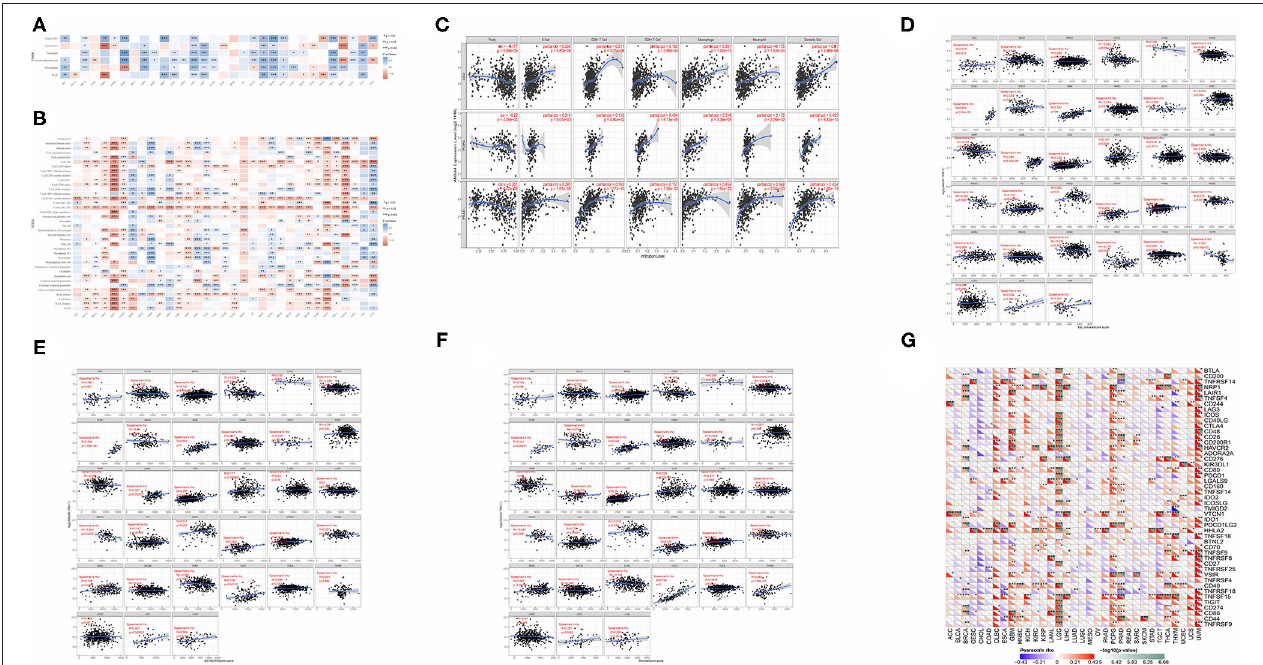
FIGURE 6 | Correlations between ANXA4 expression and immune infiltration. (A) Correlations between ANXA4 expression levels and immune infiltration in the TIMER database. (B) Correlations between ANXA4 expression levels and immune infiltration utilizing xCell. (C) Relationships between ANXA4 expression levels and immune infiltrate in top three relevant tumor types. (D) Immune score calculated through ESITIMATE. (E) Estimate score calculated through ESITIMATE. (F) Stromal score calculated through ESITIMATE. (G) Correlations between ANXA4 expression levels and immune checkpoints markers. * p < 0.05, ** p < 0.01, *** p < 0.001.